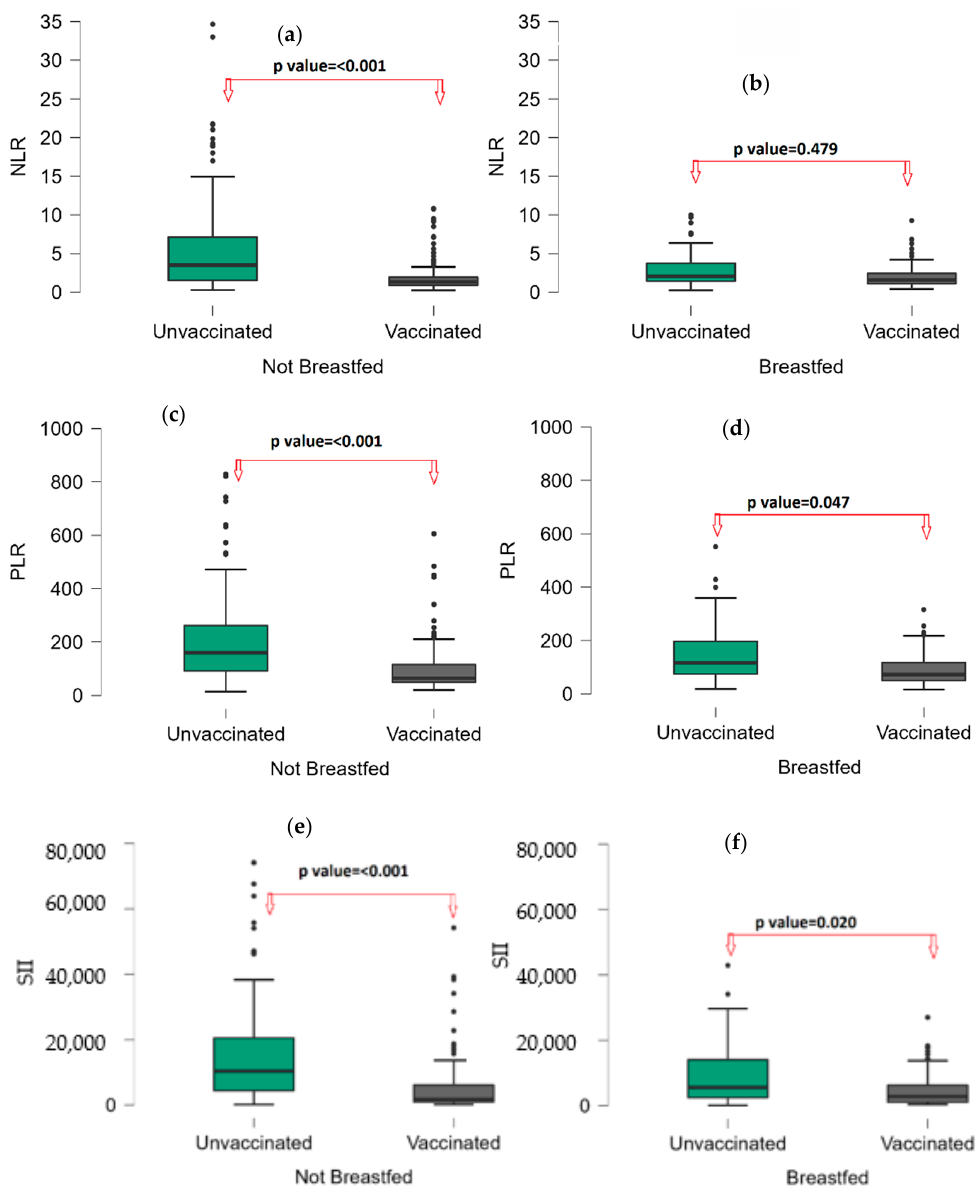
Figure 3. Box-plot graph by vaccination group in breastfeeding subgroups, ( a ): NLR in not breastfed; ( b ): NLR in breastfed; ( c ): PLR in not breastfed; ( d ): PLR in breastfed; ( e ): SII in not breastfed; ( f ): SII in breastfed; Points ( • ) are represents the outliers.